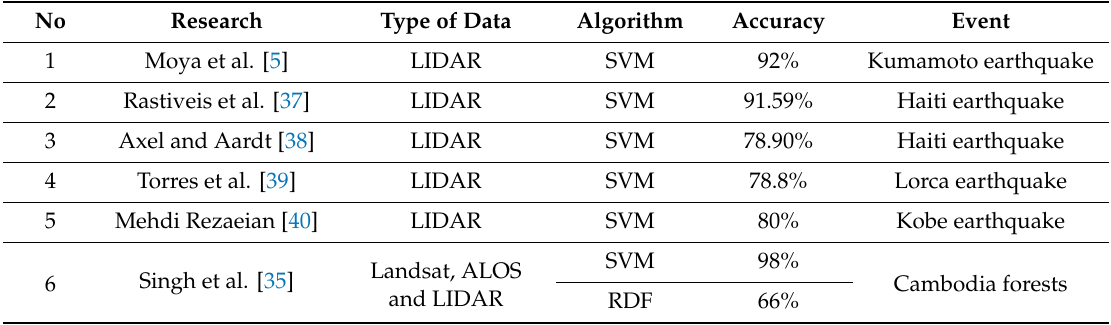
Table 4. Some examples of research done with RDF and SVM algorithms using LIDAR